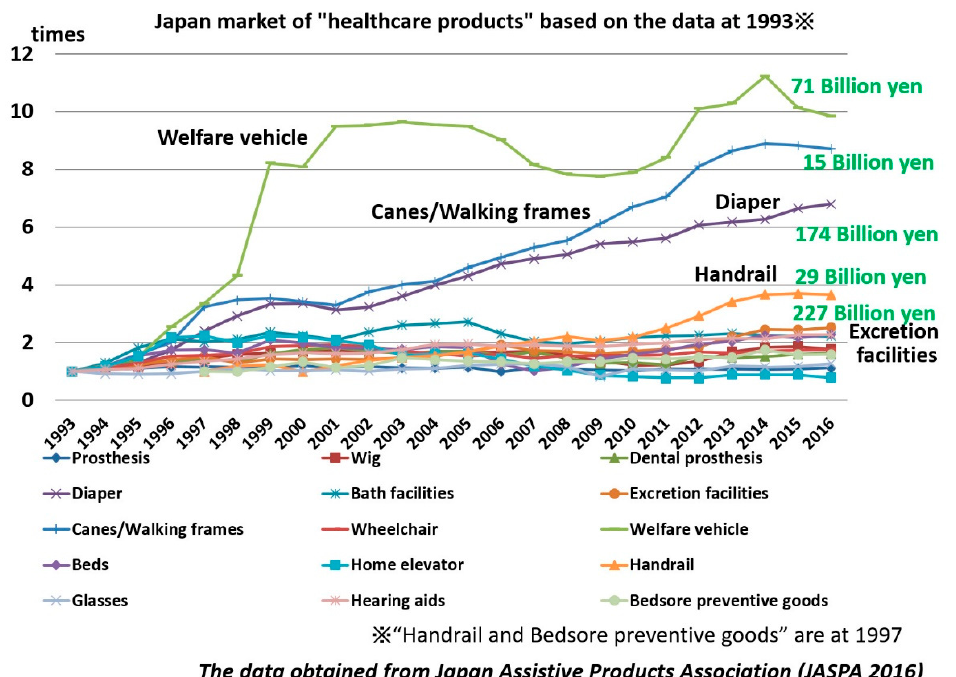
Figure 2. The developing market of welfare products in Japan.